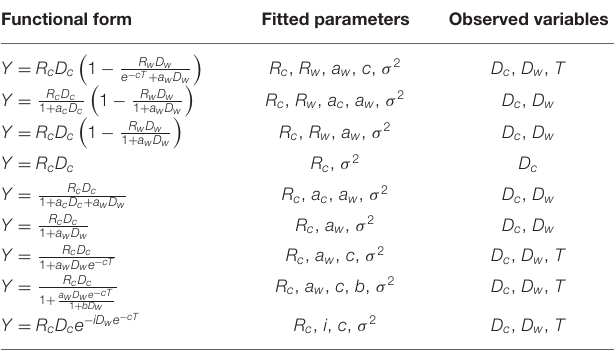
TABLE 3 | Functional forms of the models used for the barley yield simulations. Functional form Fitted parameters Observed